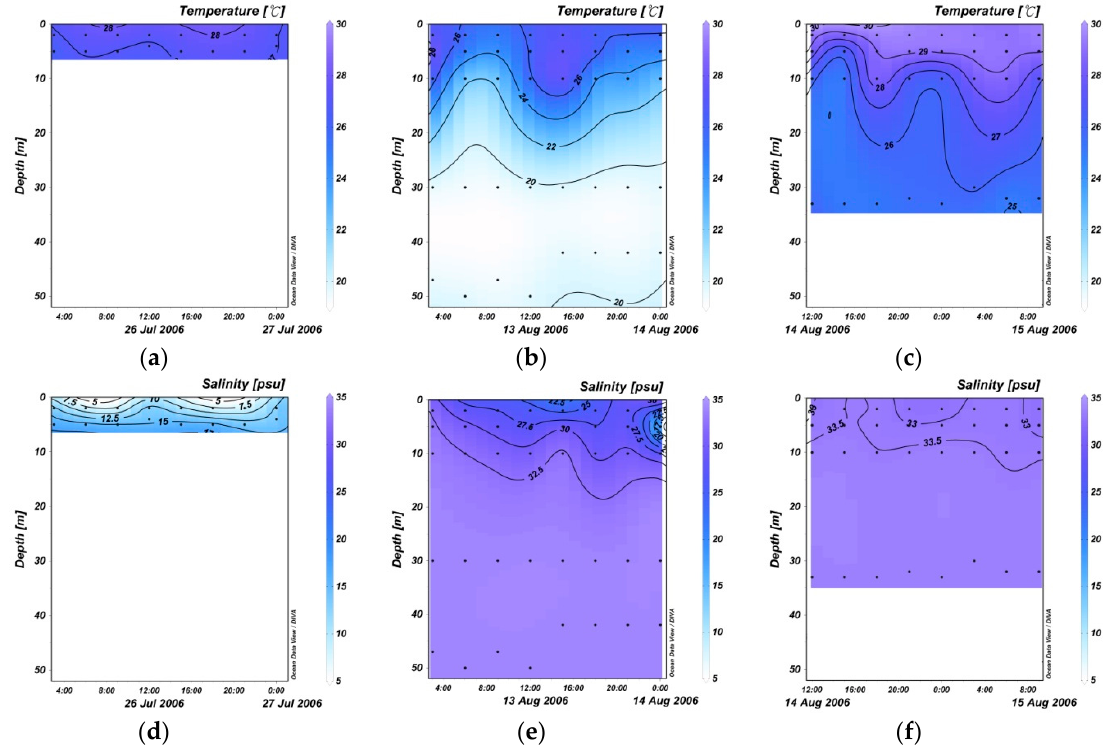
Figure 3. Twenty-four-hour variations in temperature in the near-shore ( a ), front ( b ), and offshore ( c ) regions and salinity in the near-shore ( d ), front ( e ), and offshore ( f ) regions in summer.